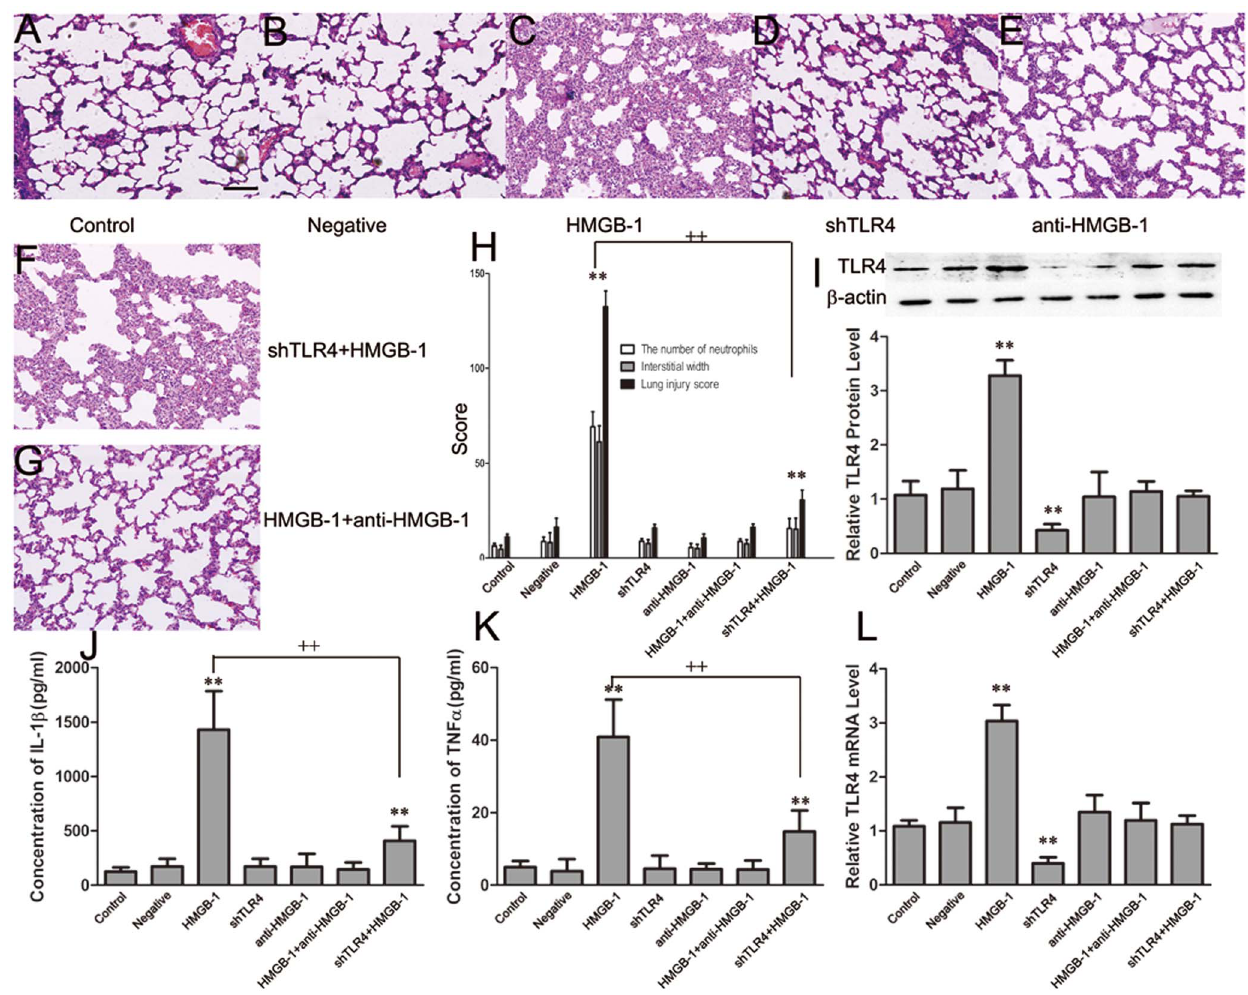
Figure 4. The effect of TLR4 inhibition on HMGB-1-induced ALI. RNAi was used to inhibit the expression of TLR4, and the animals received 100 m g of rhHMGB-1. Lung histological observation was performed after transfection and 24 h after HMGB-1 treatment. The negative and shTLR4 groups displayed normal lung structure similar to the control (A, B, and D) Stronger ALI effects were seen in the HMGB-1 group (C), but weaker ALI effects were observed in the shTLR4 + HMGB-1 group (F).The anti-HMGB-1 and HMGB-1 + anti-HMGB-1 groups also showed normal lung structure(E, G). Lung histopathological scores showed the degree of interstitial accumulation of neutrophils and edema: the HMGB-1 group was the highest, and the shTLR4 + HMGB-1 was clearly lower than the shNT + HMGB-1 group, but still higher than the other three groups (H). The levels of TNF- a and IL-1 b in lung were analyzed by ELISA after transfection and 24 h after HMGB-1 administration. The levels of IL-1 b in lung were not significantly different between the control, negative, shTLR4, and anti-HMGB-1 groups. After treatment with HMGB-1, the levels of IL-1 b and TNF- a increased dramatically in the HMGB-1 group and increased slightly in the shTLR4 + HMGB-1 group, but did not change in the HMGB-1 + anti-HMGB-1 group (J, K). TLR4 protein expression was measured by western blot analysis and TLR4 mRNA expression was measured by real-time quantitative PCR after transfection and 24 h after HMGB-1 administration. The TLR4 protein and mRNA levels were very low in the shTLR4 group, but dramatically increased in the HMGB-1 group. The levels of TLR4 expression in the other five groups were equal to each other (I, L). Data are shown as the mean 6 standard deviation (SD), n=6, * P , 0.05, ** P , 0.01 vs. control, ++ P , 0.01 vs. HMGB-1.